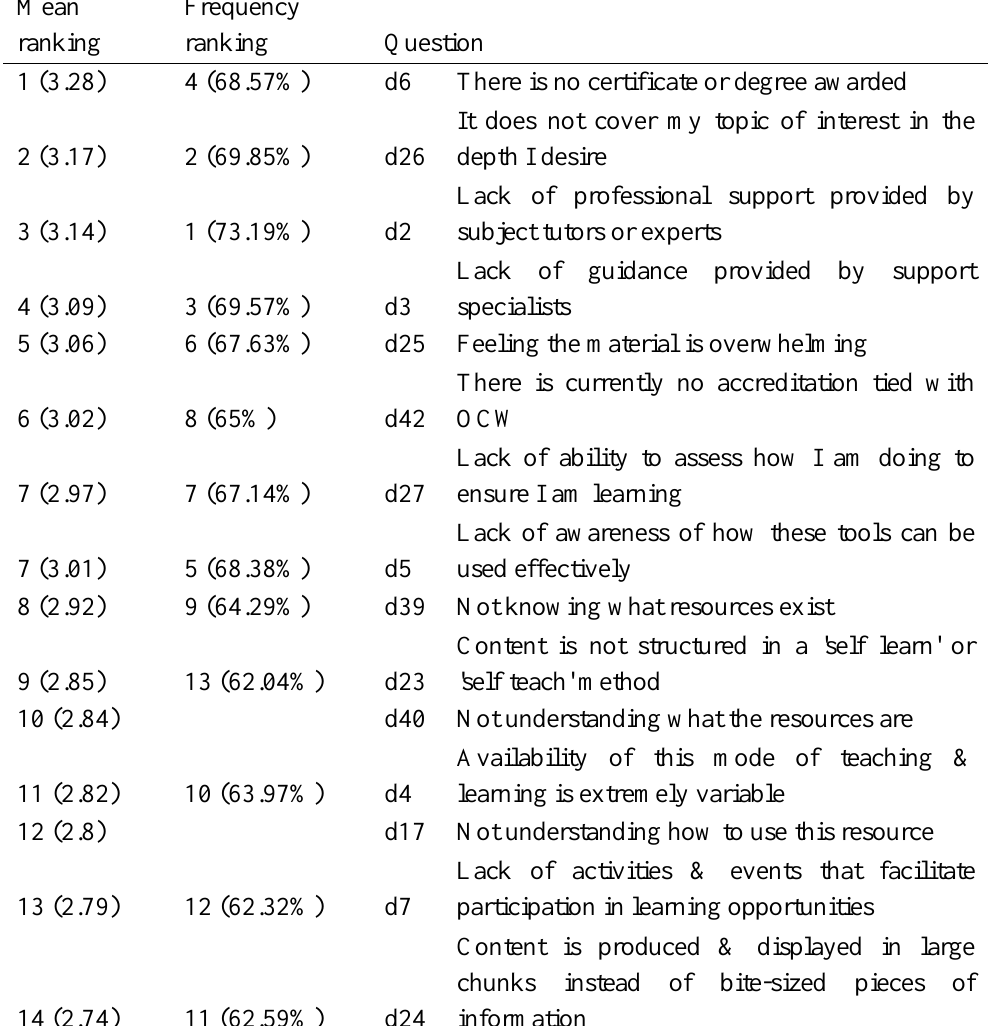
Greatest Disincentive Questions for OpenCourseWare